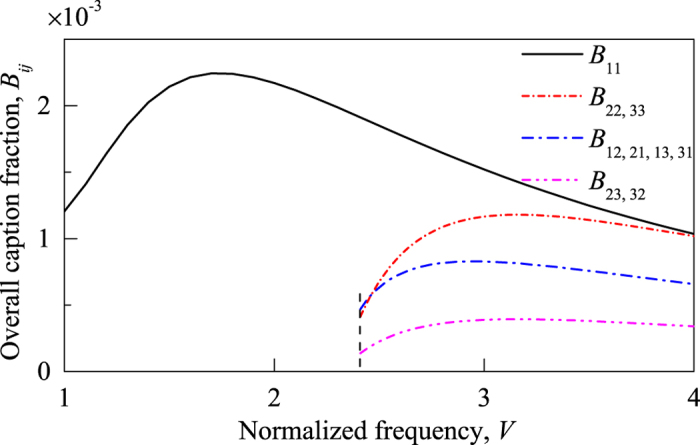
Overall capture fraction of Rayleigh back-scattering in few-mode fibers.The dashed vertical line corresponds to V = 2.405, the normalized cut-off frequency for the LP11a and LP11b modes.